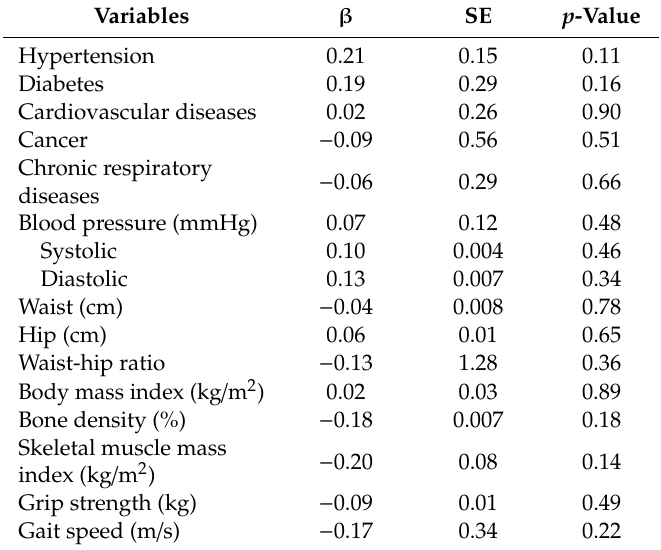
Table 7. Association of physical status related to NCDs with loneliness in Japanese older adults. Variables β SE p -Value Hypertension 0.21 0.15 0.11 Diabetes 0.19 0.29 0.16 Cardiovascular diseases 0.02 0.26 0.90 Cancer − 0.09 − diseases